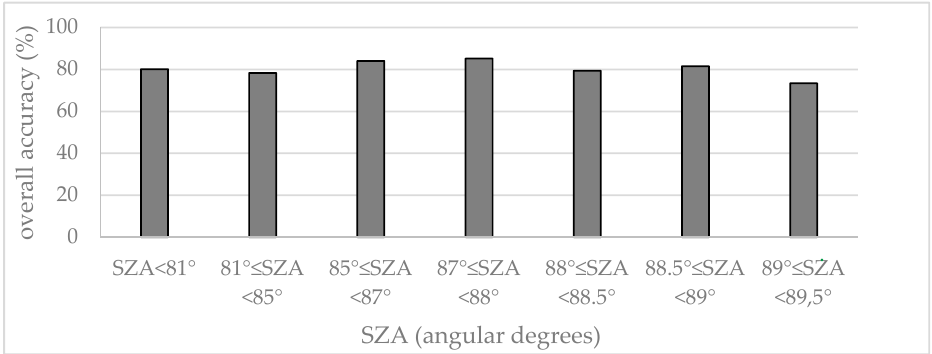
Figure 5. Overall accuracy of the snow cover classification for the different sun zenith angles classes.